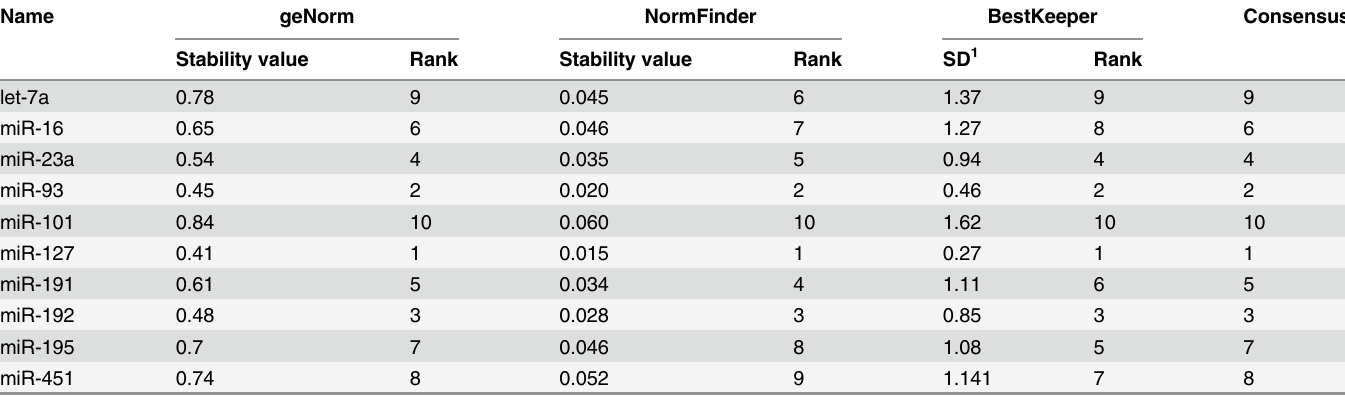
Table 1. Ranking of candidate miRNAs according to their stability value by using geNorm, NormFinder, and BestKeeper statistical algorithms.